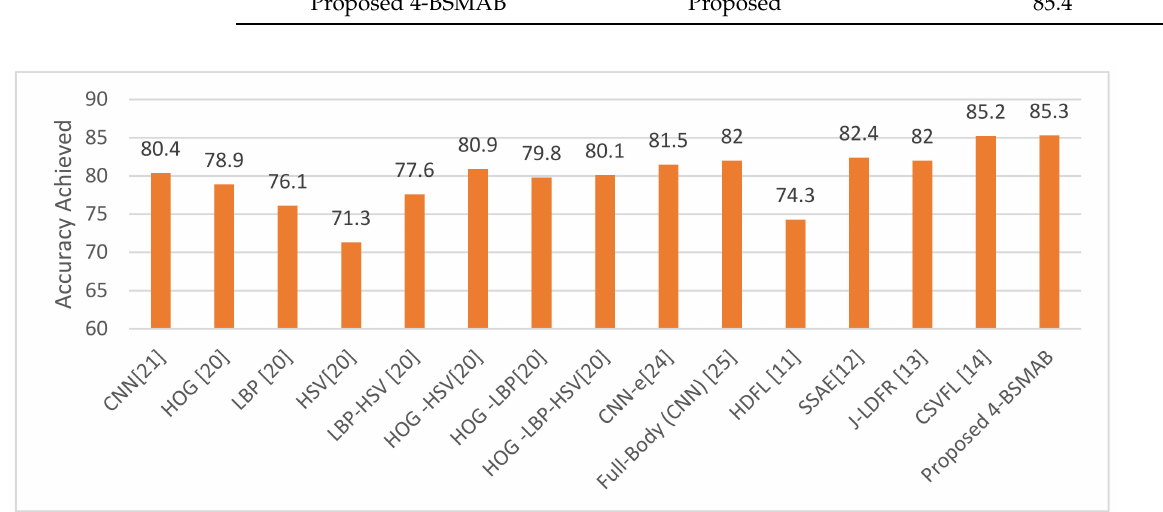
Figure 18. Comparison of accuracy obtained with proposed and existing approaches on MIT dataset.